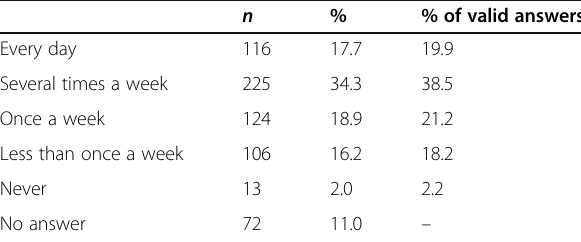
Table 3 The percentage division of children aged 10 – 13 depending on the frequency of their consumption of sweet